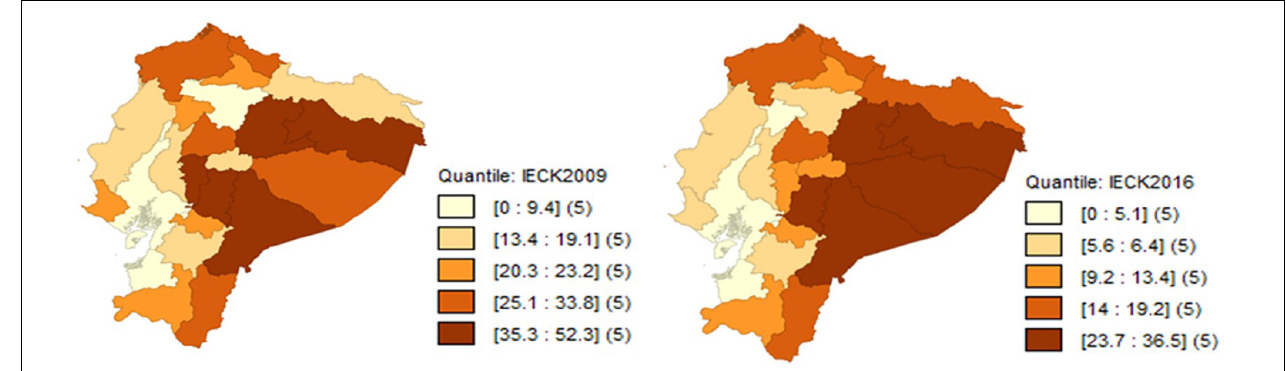
FIGURE 5 | Evolution of poverty by equivalent income with the IEOCDEM scale. Source: Own elaboration with data from ENEMDU 2009 and 2016. TABLE 3 | Sensitivity of poverty in Ecuador at the provincial level, 2009–2016. Provinces/Scales Poverty rate 2009 Poverty rate